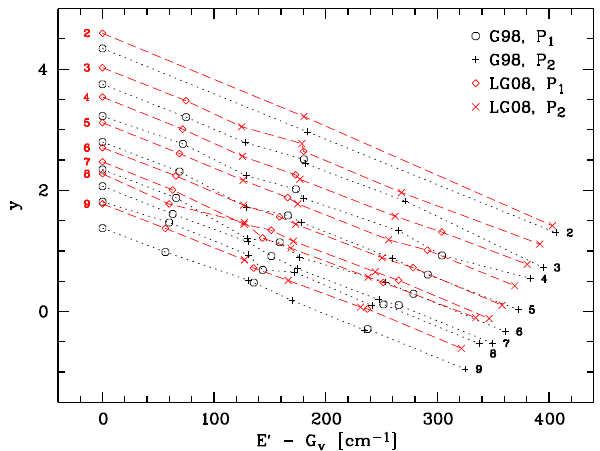
Figure 3. Derivation of OH T rot under the assumption of a Boltz- mann distribution for the different rotational upper levels. The ab- scissa shows the energy of a given level relative to the lowest rota- tional level G v of a band in cm − 1 . The ordinate displays the natural logarithm of the population of a hyperfine-structure level relative to 1 Rayleigh second. The data points indicate the mean values of E (cid:48) − G v and y derived from the sample mean intensities for the se- lected OH lines with the same v (cid:48) . The different symbols and colours distinguish lines of the P 1 - and P 2 -branches as well as the use of en- ergy values and Einstein coefficients of G98 and LG08, respectively (see legend). The dotted (G98) and dashed lines (LG08) connect OH lines with the same v (cid:48) (see